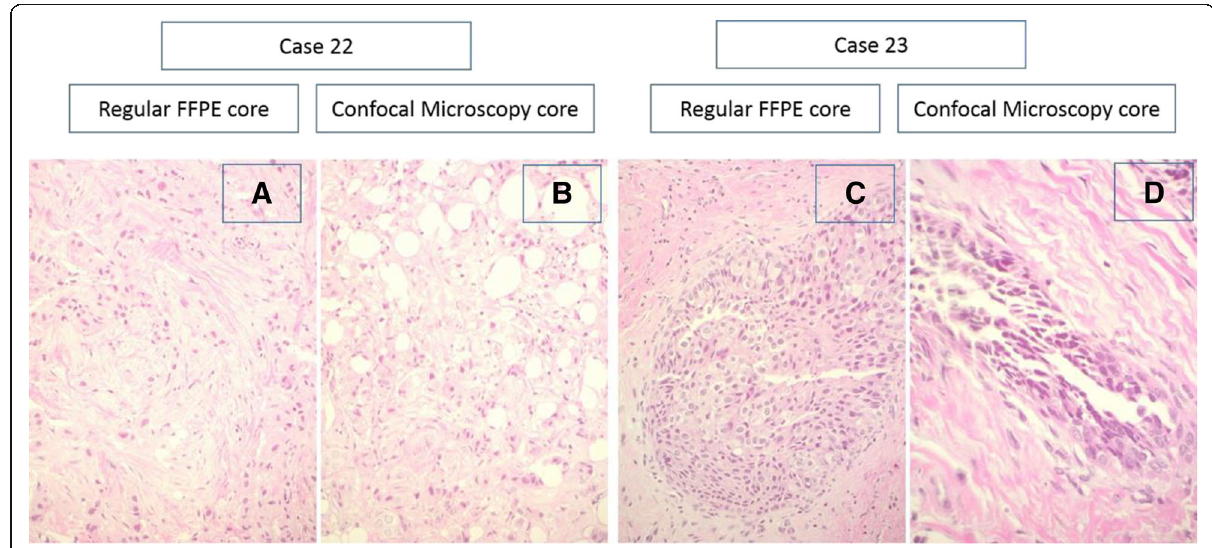
Fig. 4 Pictures show the negligibly small effect of the preparation process for scanning on the final pathologic routine: On-site scanning procedure does not interfere with the subsequent control H&E process. HE stains and high magnification histological appearance of two cases. Case 22 ( a / b ): invasive ductal (NST) carcinoma. a HE stain, regular formalin fixation. b HE stain, formalin fixation after confocal microscopy. Case 23 ( c / d ): high grade DCIS c ) HE stain, regular formalin fixation. d HE stain, formalin fixation after confocal